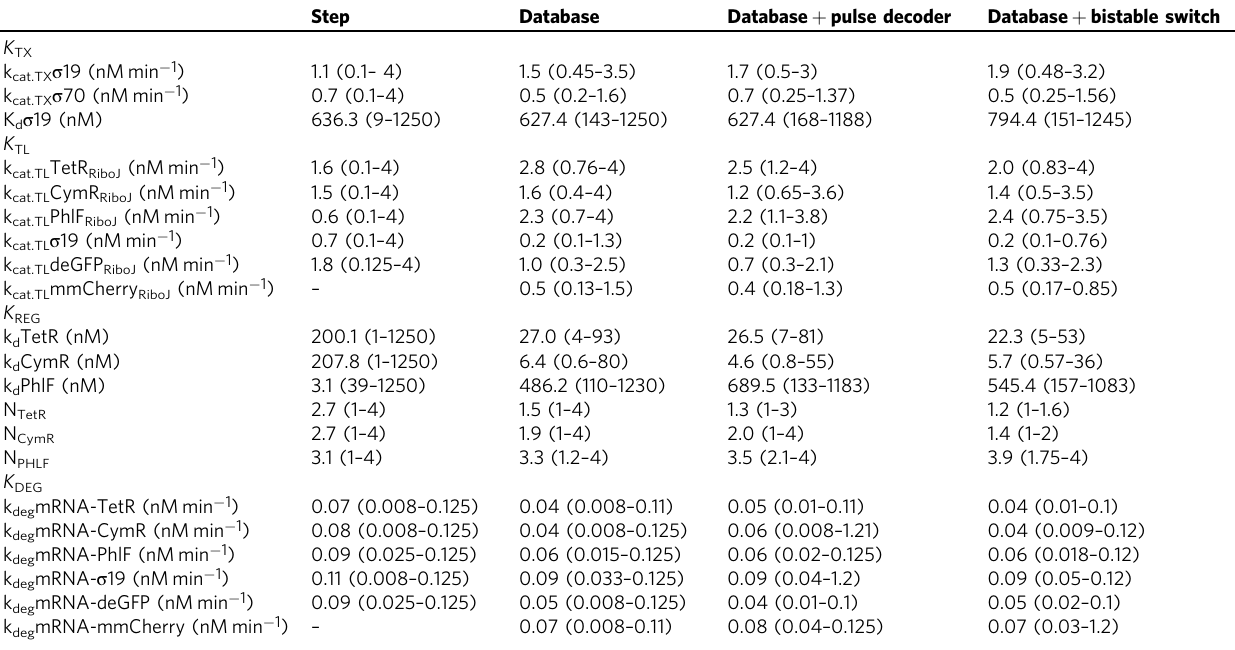
Table 1 Parameter values and distributions.